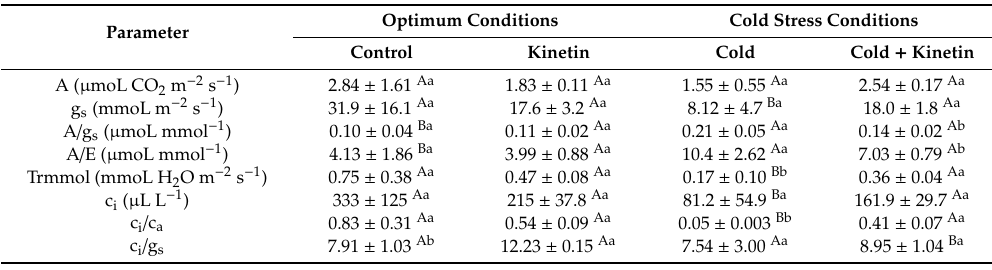
Table 1. E ff ect of exogenous kinetin on the net CO 2 assimilation rate (A), stomatal conductance (g s ), intrinsic water-use e ffi ciency (A / g s ), instantaneous water-use e ffi ciency (A / E), transpiration rate (TrmmoL), intracellular CO 2 concentration (C i ), internal to ambient CO 2 concentration ratio (C i / C a ) and mesophyll e ffi ciency in the leaves of co ff ee seedlings under optimum and cold stress conditions, 25 / 20 ◦ C and 12 / 12 ◦ C,